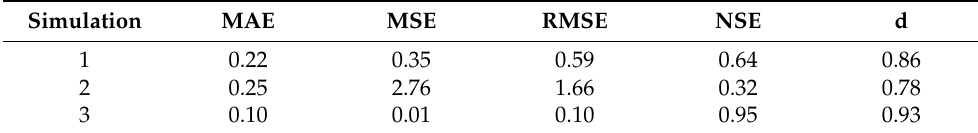
Table 8. Indices for the performance of the models. (MAE: Mean Absolute Error; MSE: Mean Squared Error; RMSE: Root Mean Squared Error; NSE: Nash–Sutcliffe Efficiency coefficient; and d: Index of agreement.